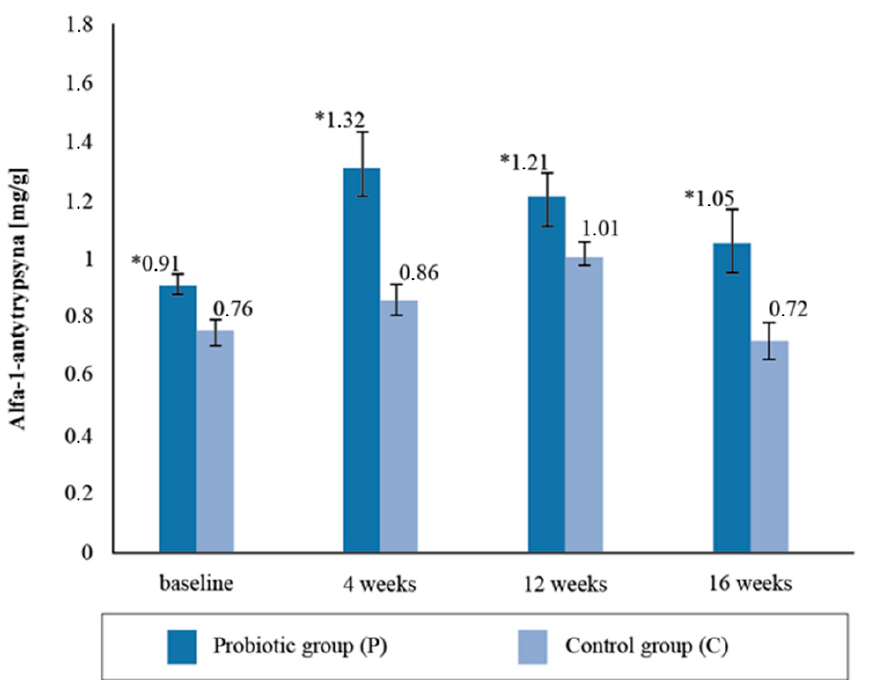
Figure 4. Alfa-1-antytrypsin concentration in the stool sample at follow-up measurements points during supplementation intervention. * statistically significant intergroup differences ( p < 0.05).